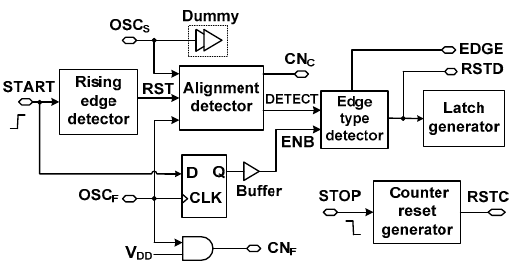
Figure 3. Block diagram of the digital controller.